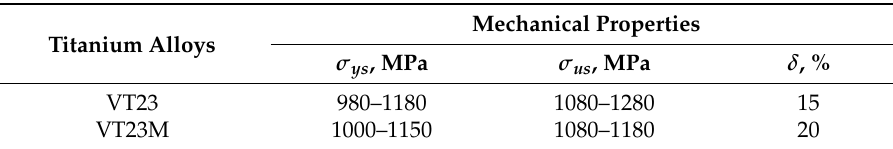
Table 2. Mechanical properties of titanium alloys VT23 and